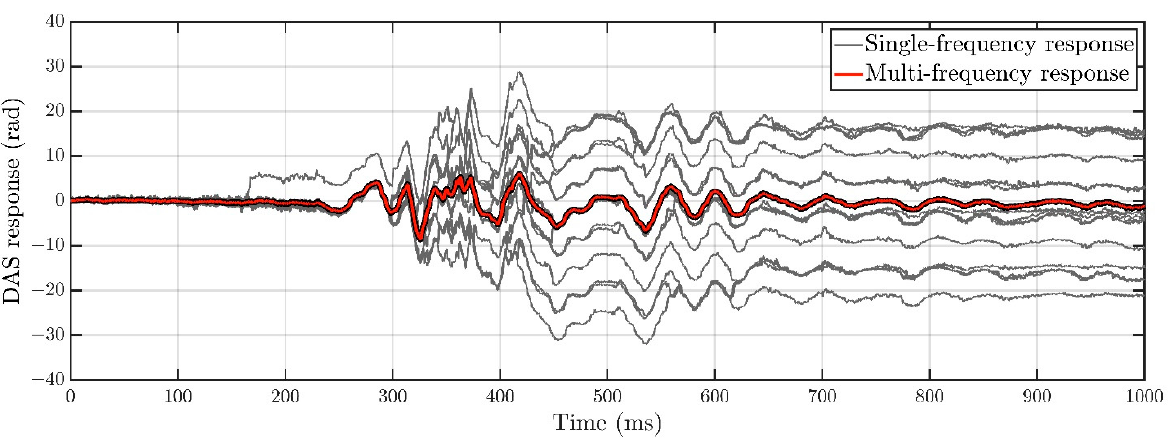
Figure 5. The DAS response in one spatial channel at 16 interrogation frequencies with visible phase